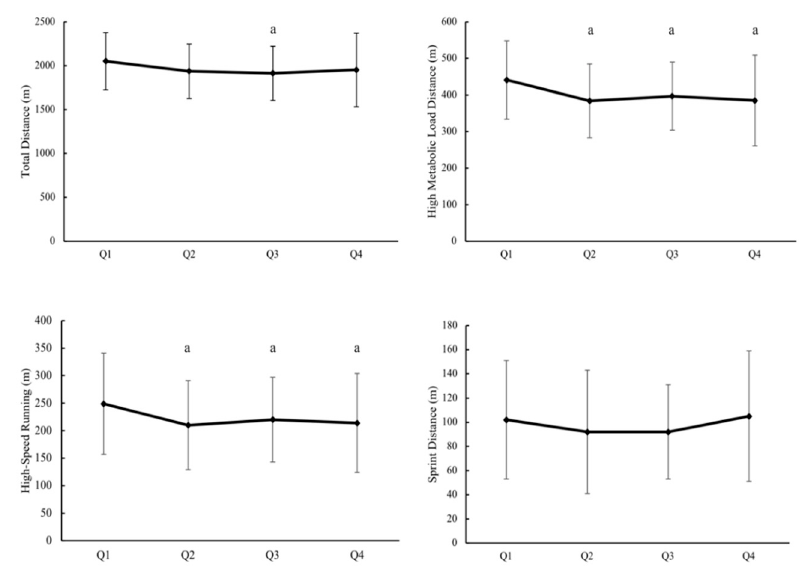
Figure 1. Mean ± SD total-, high-speed running-, sprint- and high metabolic load-distance covered per quarter is shown. Q = quarter, a = different ( p < 0.05) from quarter 1. Differences between quarters within each playing position is presented in Figure 2. Full backs ( d = 0.57), half backs ( d = 0.46), and half forwards ( d = 0.58) covered greater total distance in Q1 compared to Q2. Full backs ( d = 0.55), half forwards ( d = 0.81), and full forwards ( d = 0.59) covered greater total distance in Q1 compared to Q3. Half forwards experienced a further reduction in total distance covered in Q4 ( d = 0.96) compared to Q1. Full forwards covered a lower total distance in Q3 ( d = 0.60) compared to Q2. There was no other di ff erence in total distance covered between quarters in any other position ( p > 0.05).